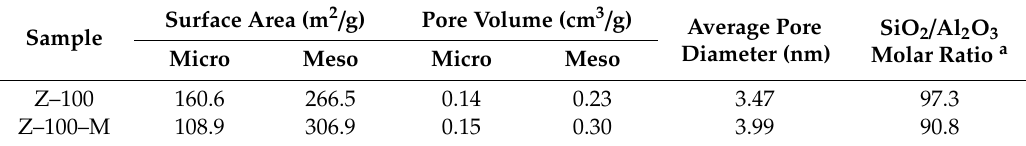
Table 3. The physical properties of different catalysts.